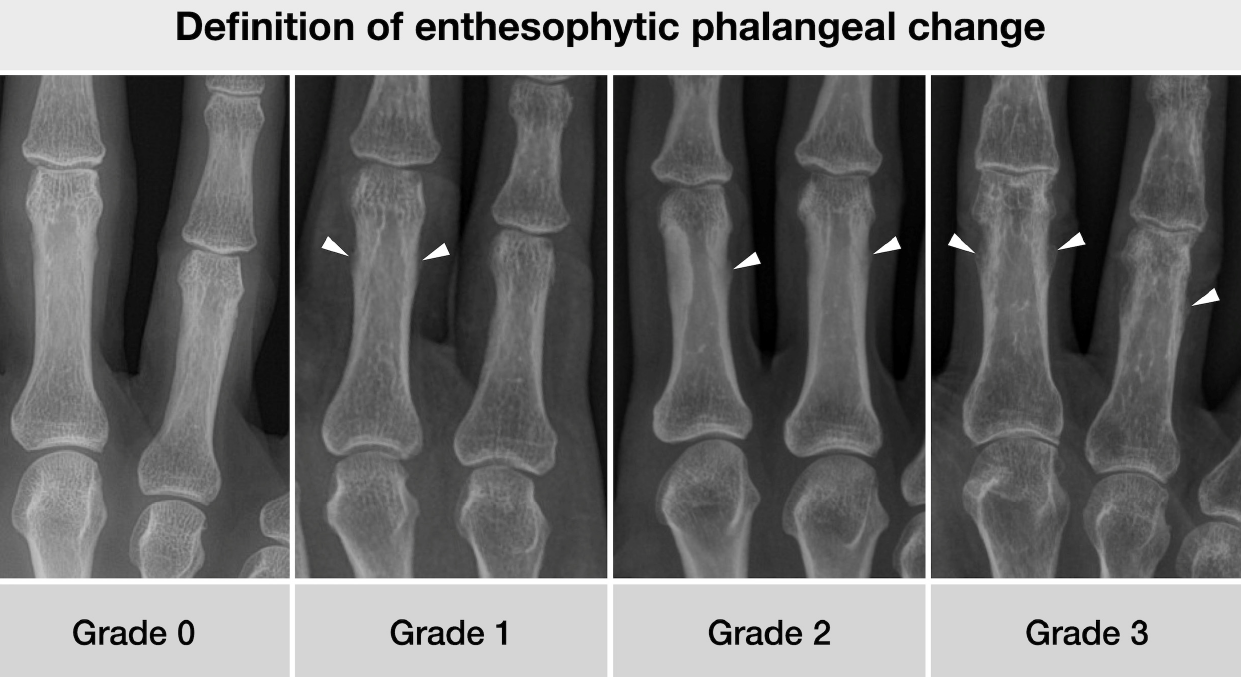
Figure 2. Anterior-posterior X-ray examples of the different grades of enthesophytic growth. Patients’ characteristics from left to right: 53 y/o female, 59 y/o male, 57 y/o female, 82 y/o male.